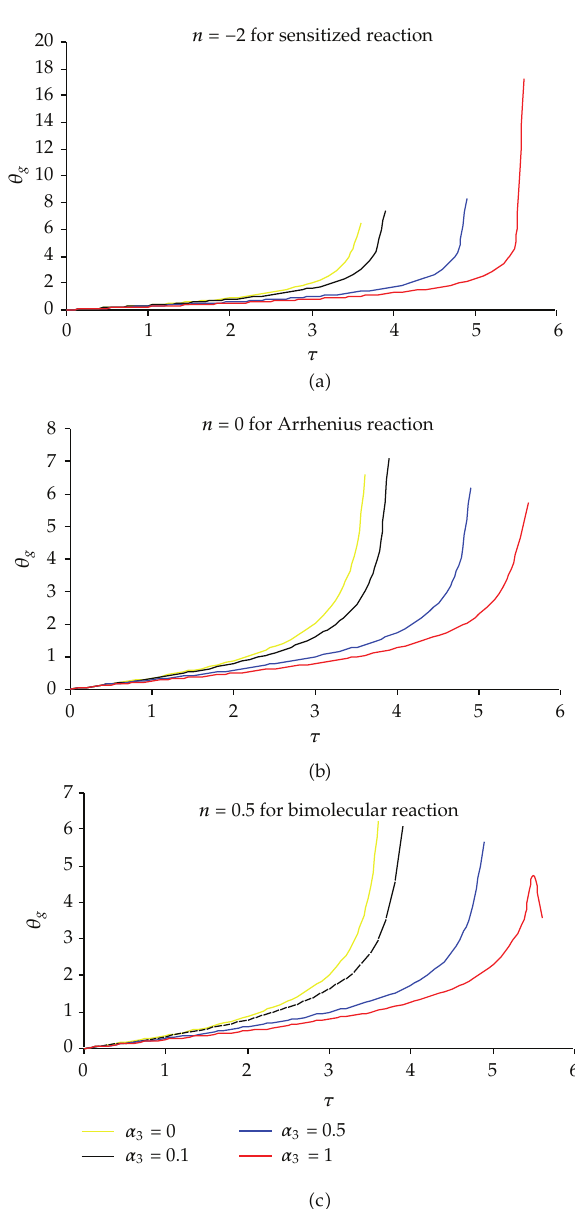
Figure 1: Variation of dimensionless combustible gas temperature with interphase heat exchange param- eters when n (cid:7) {− 2 , 0 , 0 . 5 }